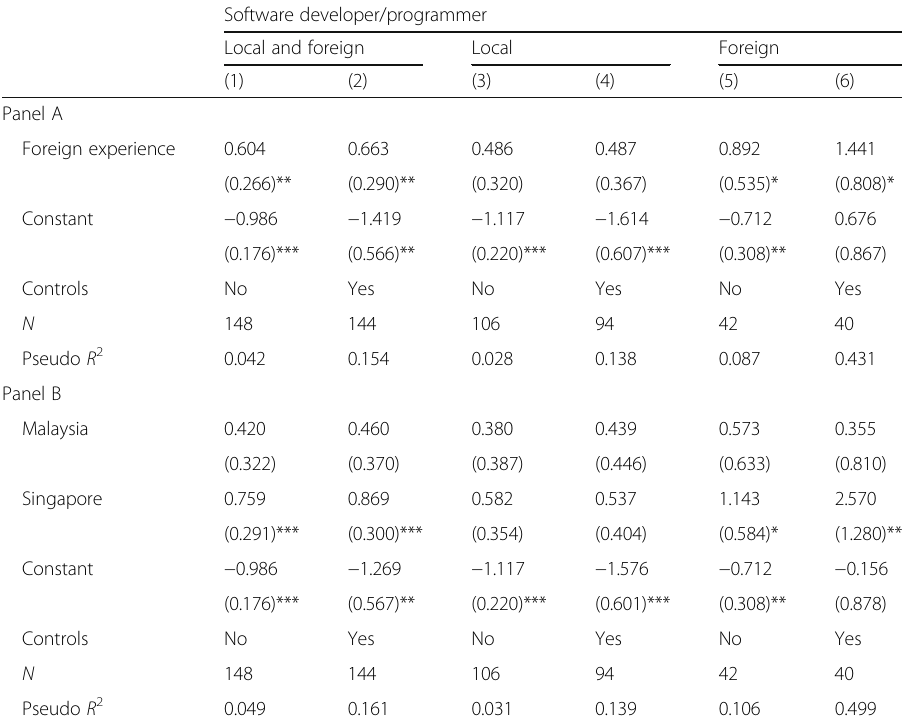
Table 14 Dependent variable: if a resume is the first to receive a callback for an interview (software developer/programmer)